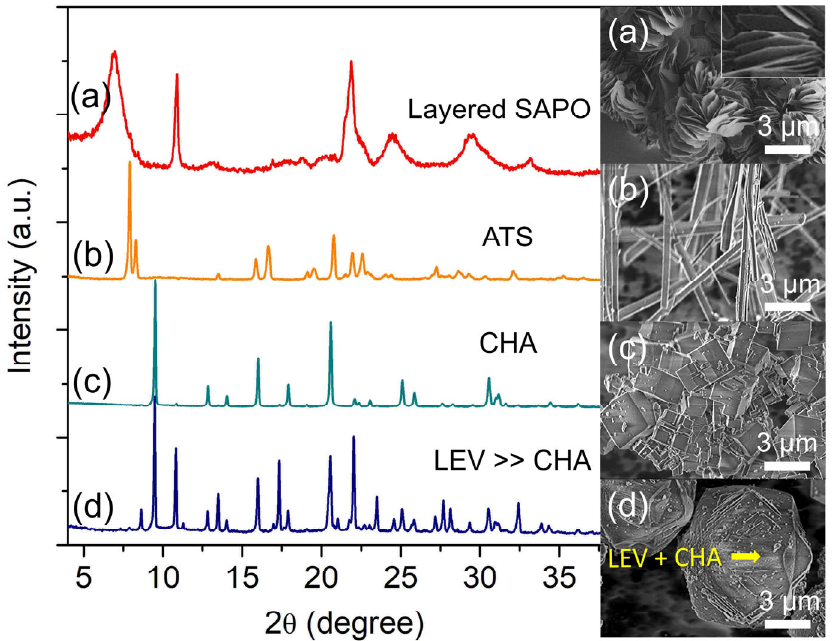
Figure 3. XRD patterns and FESEM micrographs of ( a ) S-8 ( x = 0), ( b ) S-9 ( x = 0.4), ( c ) S-3 ( x = 0.9), and ( d ) S-10 ( x = 1.3) samples. The samples were prepared using the hydrogel of 2.0 Al: 4.7 P: x Si: 6.7 [PrPy]OH: 148 H 2 O heated at 200 °C for 19 h.